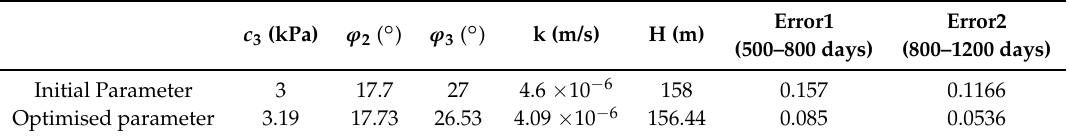
Table 3. Model calibration and